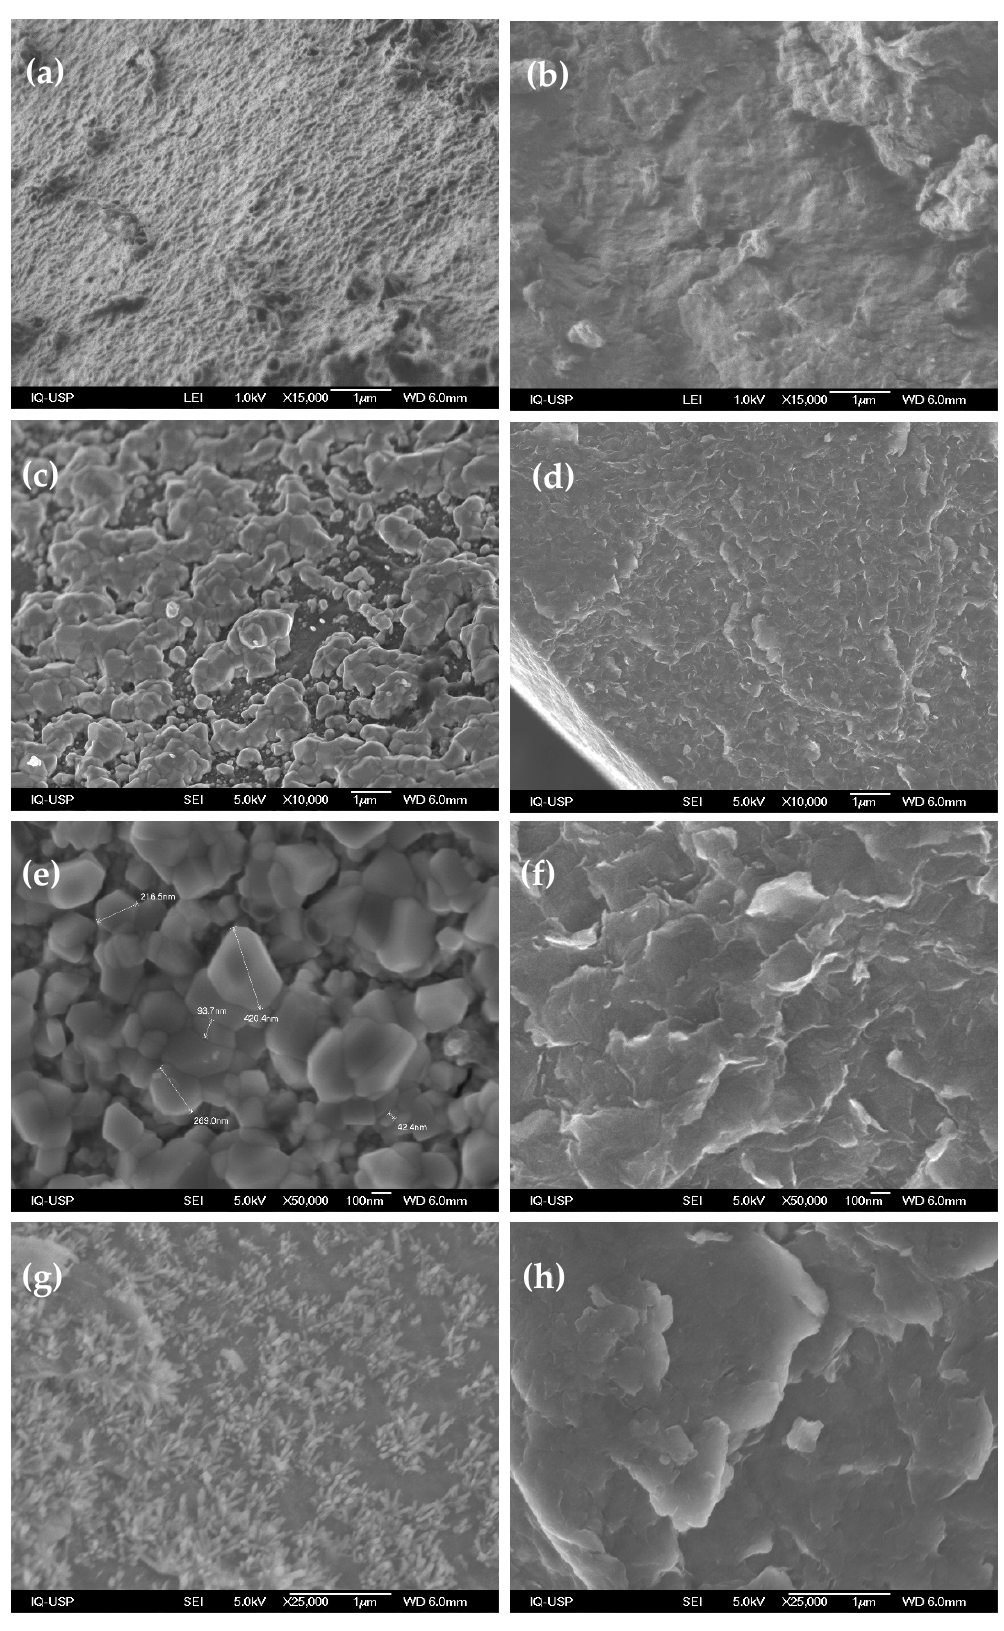
Figure 9. SEM micrographs of MMO / C samples obtained from Zn 2 Al-CMC (left) and Mg 2 Al-CMC (right) as synthesized ( a, b ) and pyrolyzed at 800 ( c, d, e, f ) and 1000 °C ( g, h ).